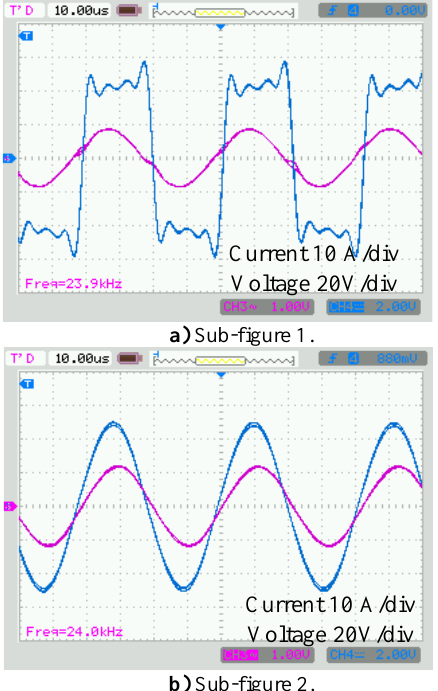
Figure 8. For 50 V DC bus voltage and 24 kHz switching frequency voltage (blue) and current (purple) at the (a) input and (b) load resistance ( R L